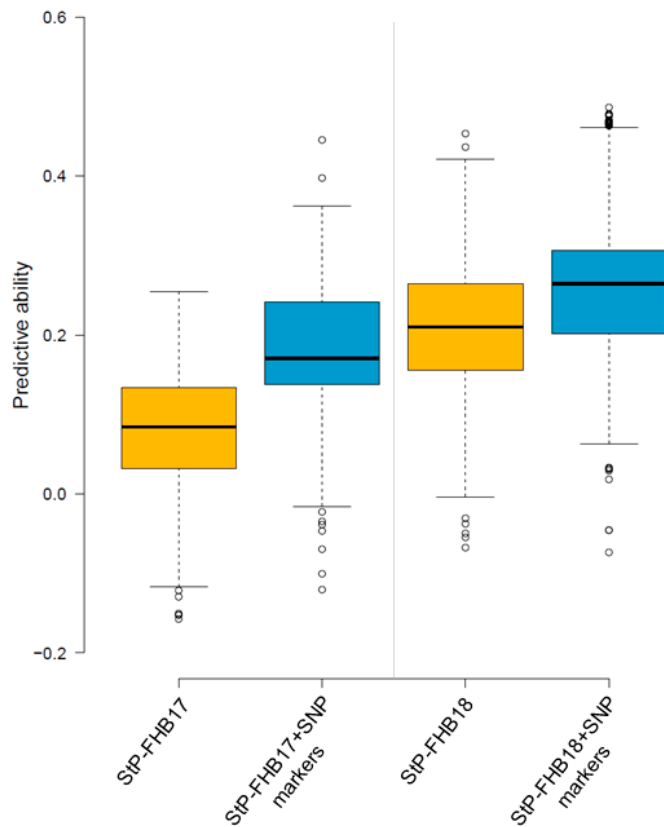
Figure 6. Predictive ability of Fusarium head blight (FHB) estimated by the ridge regression model in rrBLUP. SNP markers associated with FHB resistance in this study were used as fixed effects in the model to predict trait data collected in St. Paul, MN in 2017 (StP-FHB17) and 2018 (StP-FHB18). Each boxplot represents 1000 data points, i.e., correlations between the predicted trait value and actual trait value observed in the field obtained from 1000 independent runs.